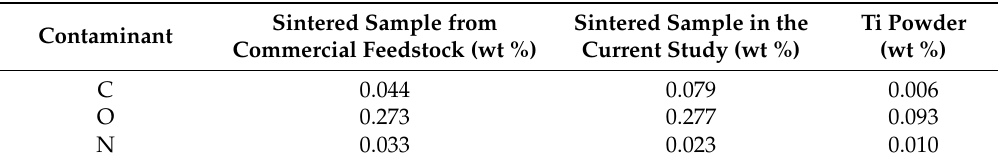
Table 3. Chemical analysis